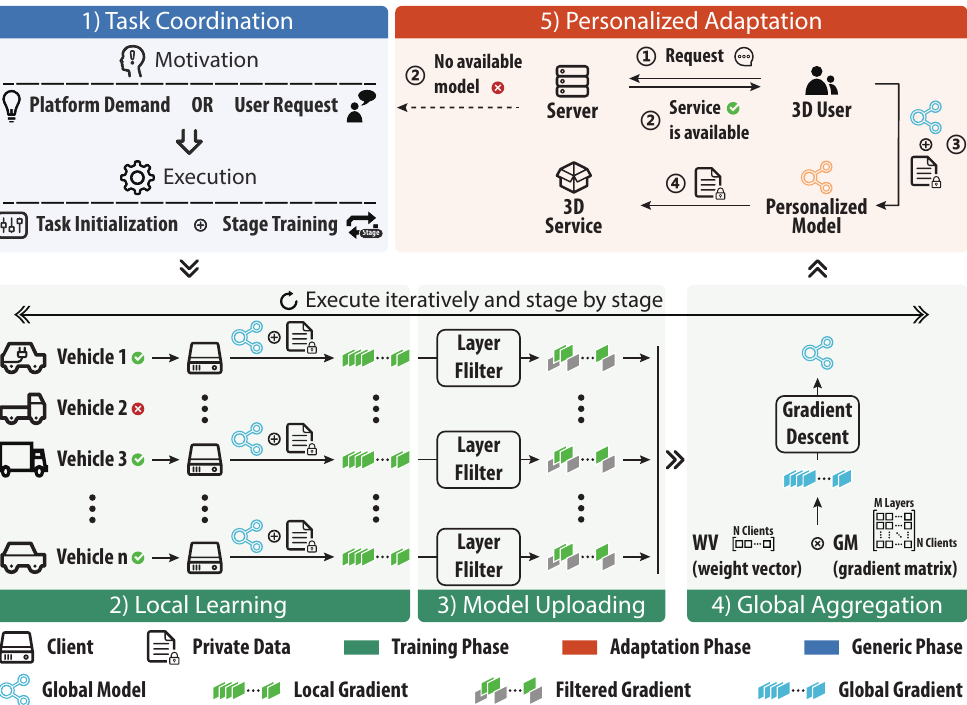
Figure 1. The overall workflow of ICMFed. Specifically, stage 1 is the generic phase supporting both training and adaptation phases; stages 2 to 4 belong to the training phase, executing training iteratively and stage by stage; and stage 5 is the adaptation phase to quickly train personalized models for the